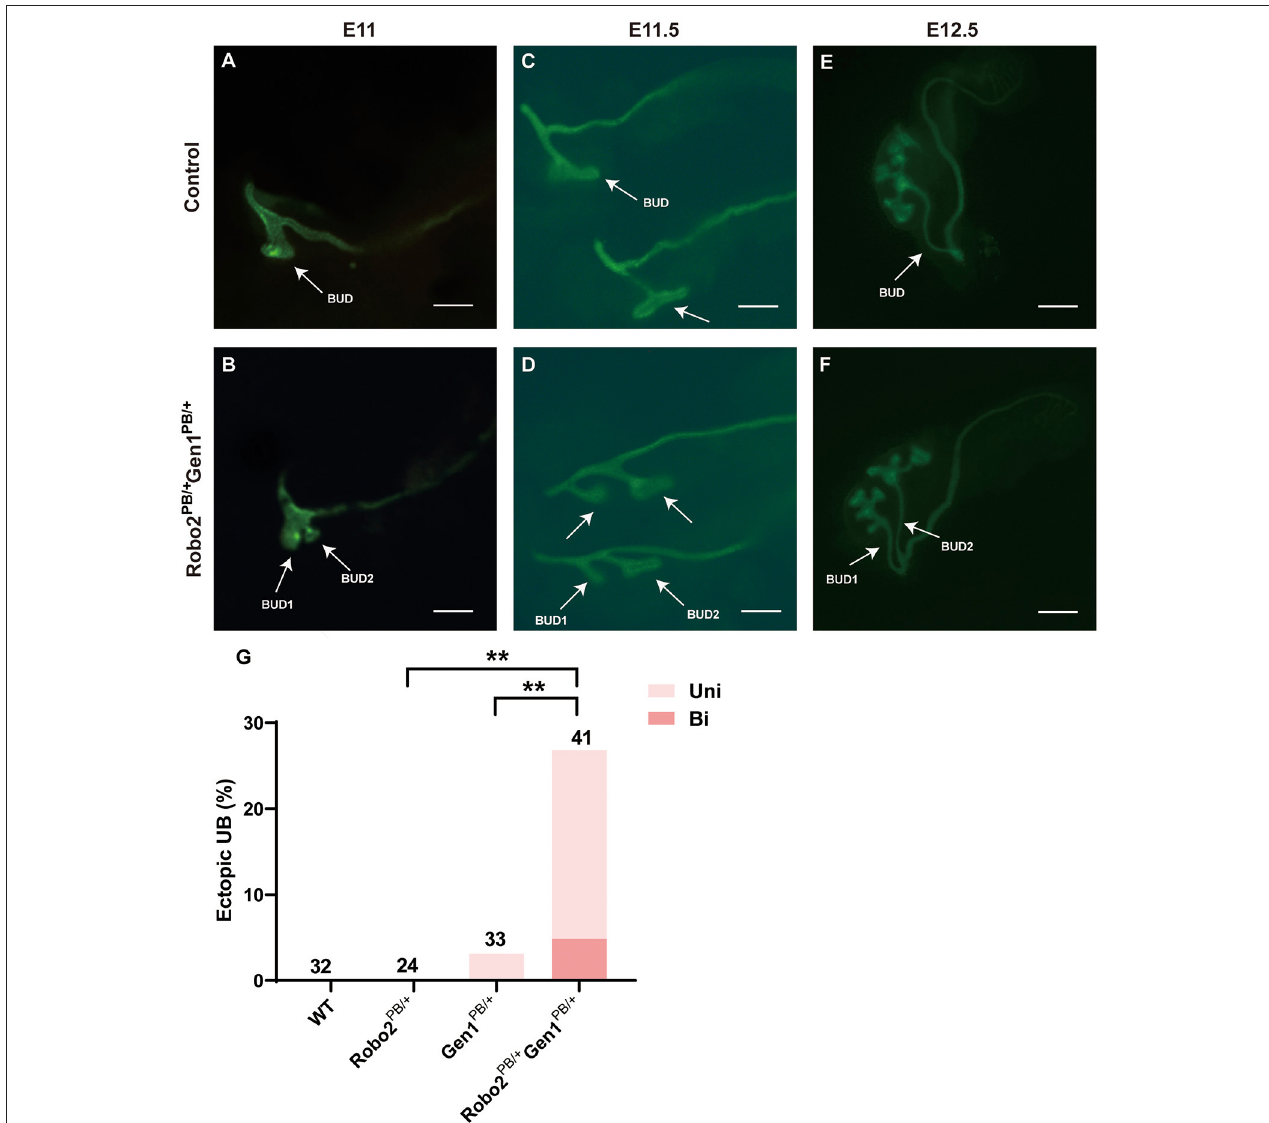
FIGURE 3 | Comparison of ureteric budding in the four groups. (A–F) Staining of whole mounts of the Robo2 PB / + Gen1 PB / + mutants at E11 (A) , E11.5 (C) , and E12.5 (E) visualized using Hoxb7 /myr-Venus expression shows abnormal ectopic ureteric budding compared with the single normal UB observed in the WT mice (B,D,F) . (G) Summary of the ectopic budding incidence in the WT, Robo2 PB / + , Gen1 PB / + , and Robo2 PB / + Gen1 PB / + kidneys. The ectopic budding incidence is shown as the number of kidneys with ectopic budding or branching/total number of kidneys examined. Uni, Unilateral; Bi, Bilateral. Scale bars represent 100 µ m in A-D. Scale bars represent 200 µ m in E-F. NS, non-significant; ** P <